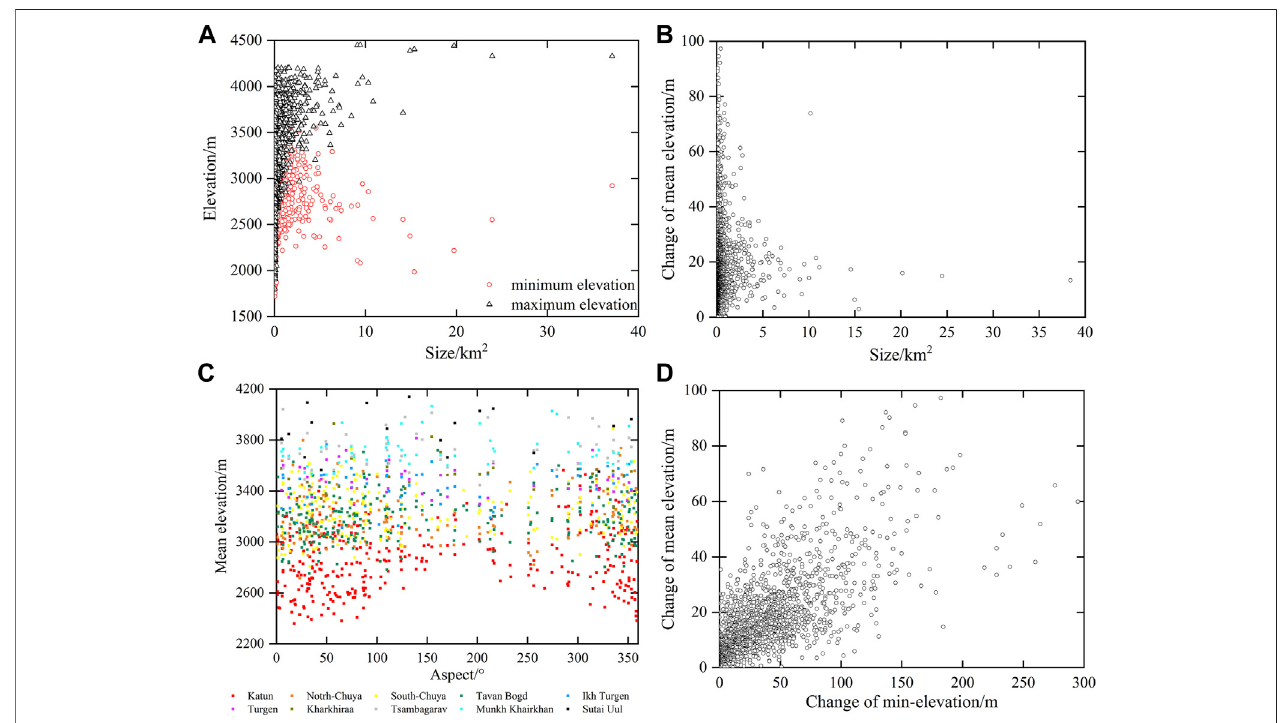
FIGURE 9 | (A) Glacier size vs. min-elevation and max-elevation in 2020. (B) Glacier size vs. changes of mean elevation for 2000 – 2020. (C) Aspect vs. mean elevation over glaciers in the main mountain ranges in 2020. (D) Change of minimum elevation vs . change of mean elevation for 2000 – 2020.